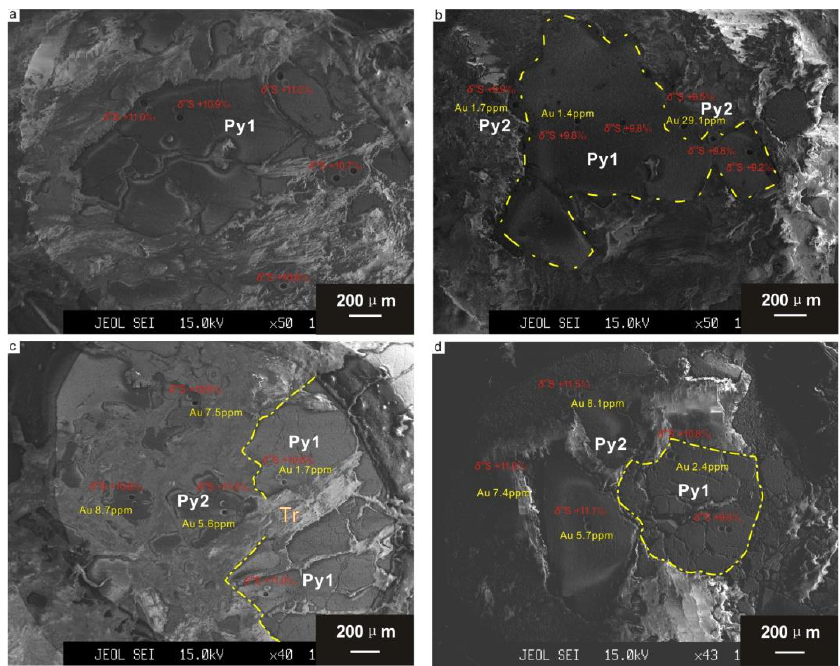
Figure 7. BSE images of ore-bearing pyrites in the Lijiapuzi deposit. In situ Au and δ 34 S values are shown. ( a ) Early-stage pyrite with relatively low Au contents. ( b – d ) Py2 coexisted with tremolite distributing on the margin of early-stage pyrite. Py1 — early-stage pyrite; Py2 — late-stage pyrite; Tr —